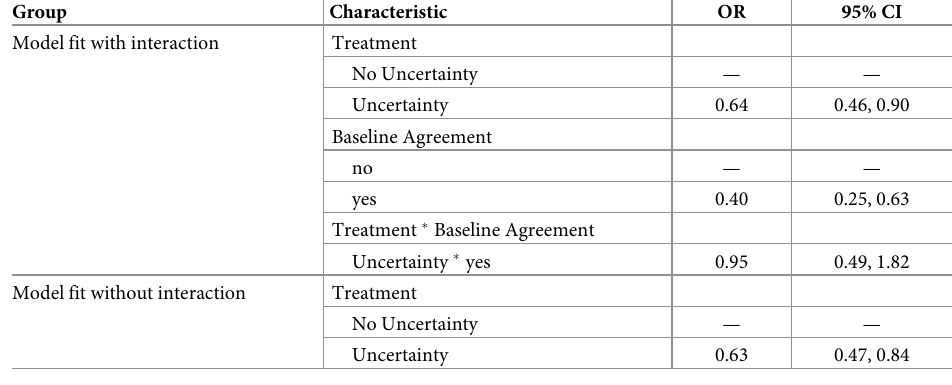
Table 4. Proportional odds model examining the impact of seeing uncertainty in the initial recommendation on accepting that